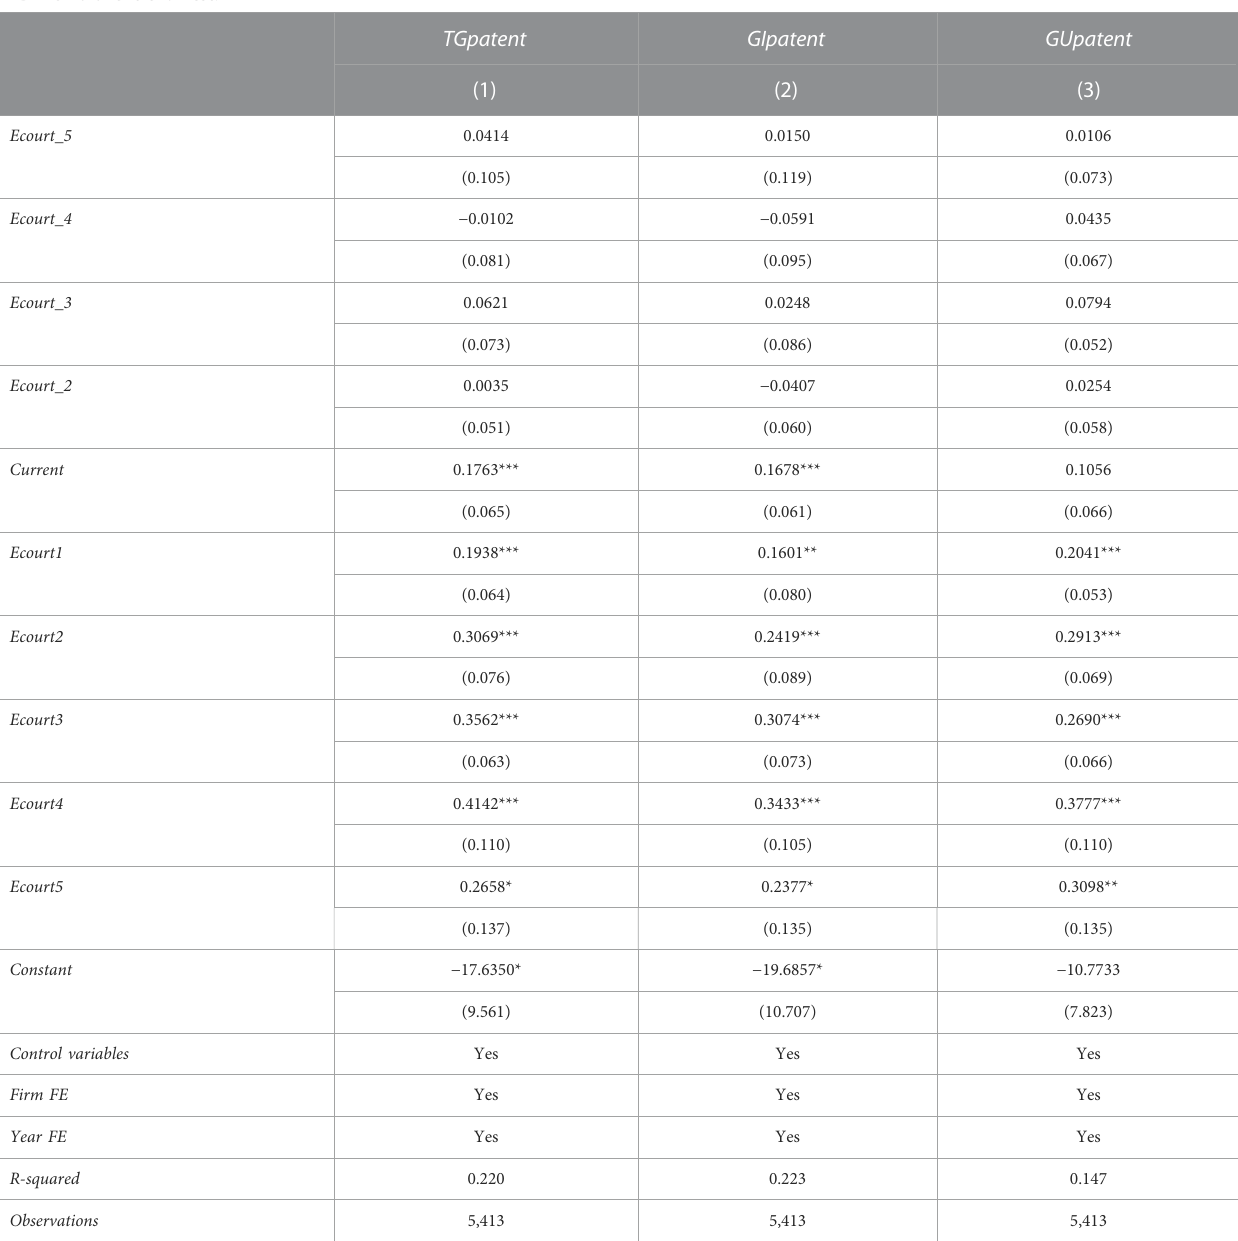
TABLE 3 Parallel trend Test. TGpatent GIpatent